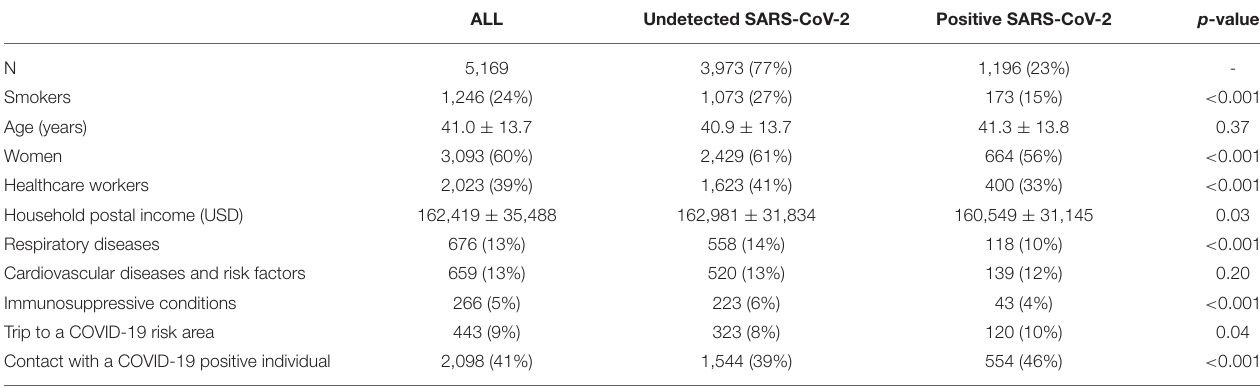
TABLE 1 | Population characteristics (overall and stratified by SARS-CoV-2 test results).